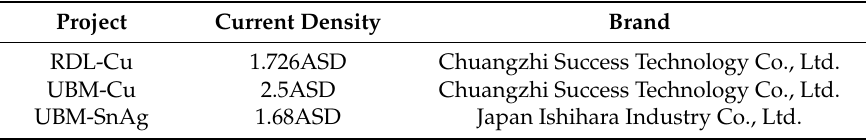
Table 1. Current density of di ff erent parts, brand of Cu and SnAg plating